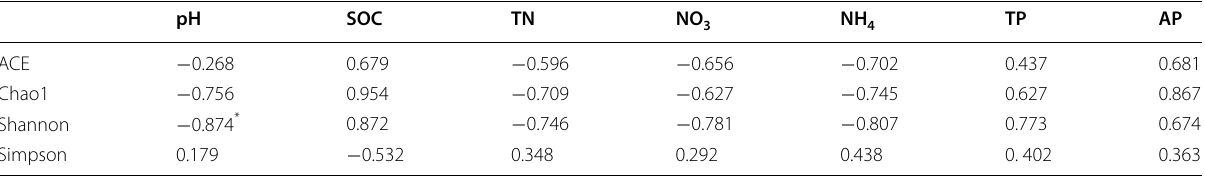
Table 3 Correlation coefficients of bacterial alpha diversity indices and soil physicochemical factors under different nitrogen